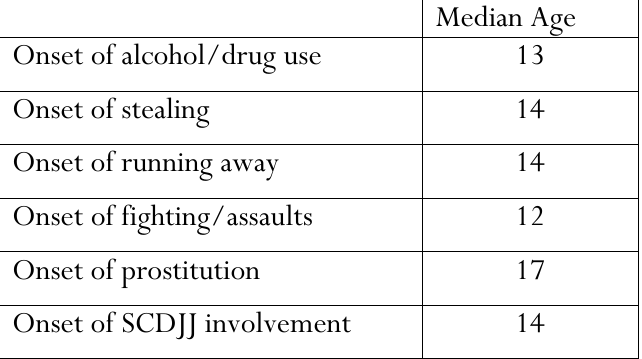
Table 8: Median Survival Time to